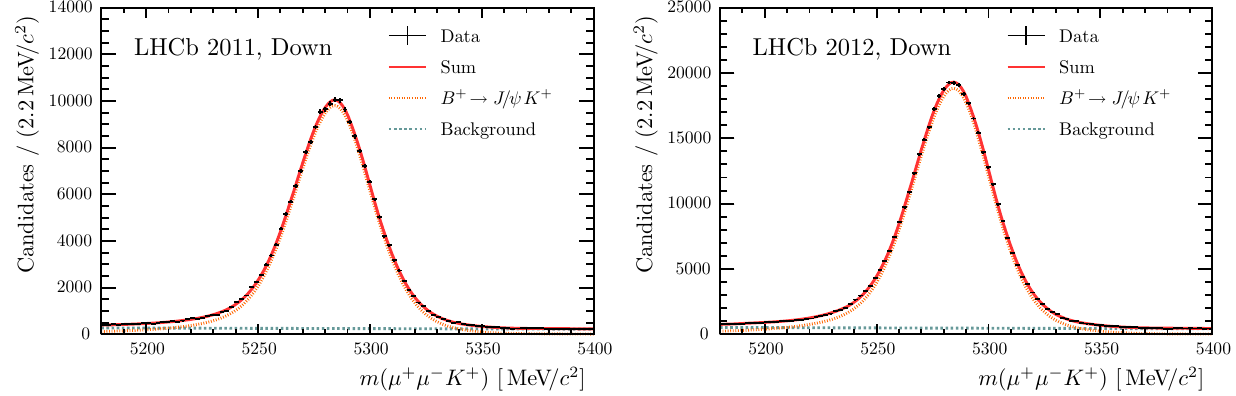
Fig. 2 The μ + μ − K + invariant mass distributions for the (left) 2011 and (right) 2012 data sets with down magnet polarity